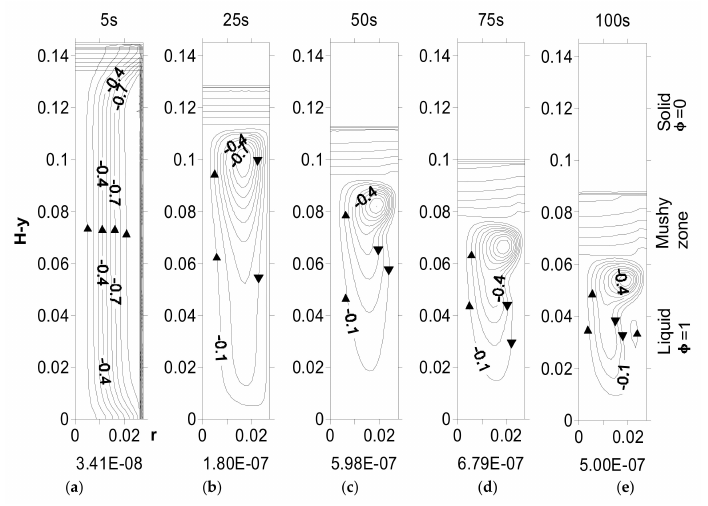
Figure 15. Development of contours of normalized stream function during solidification for simula- tion S5 without effect of ∆ T for t = ( a ) 5 s; ( b ) 25 s; ( c ) 50 s; (d)75s; and ( e ) 100 s. The magnitudes of maximum stream function (m 3 .s − 1 ) are presented at the bottom of ( a – e